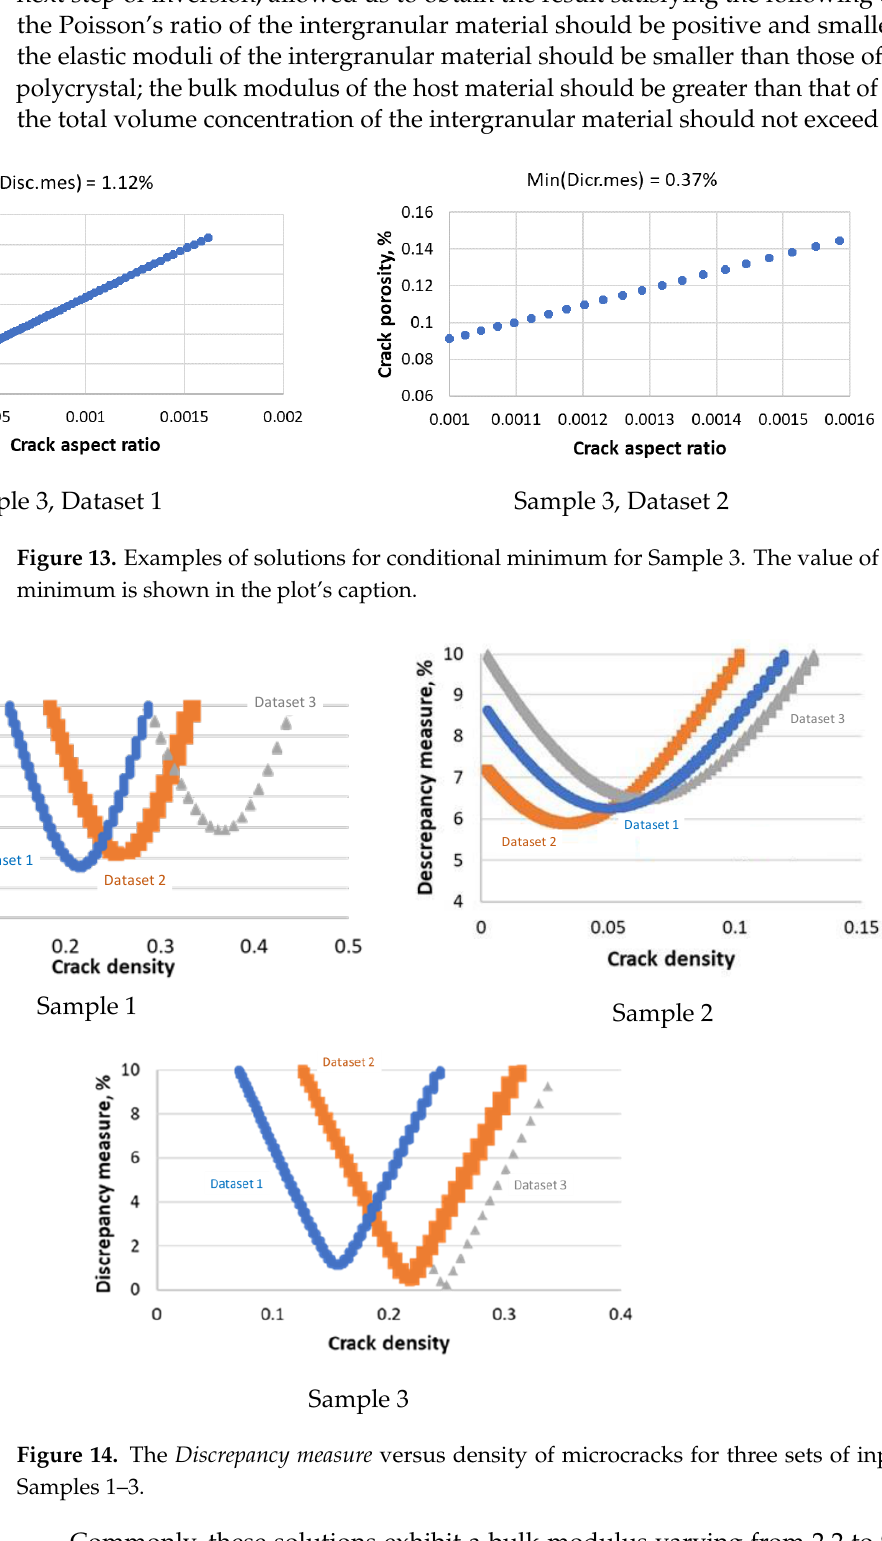
Figure 12. Surfaces of characteristic Discrepancy measure (%) versus microcrack porosity and their